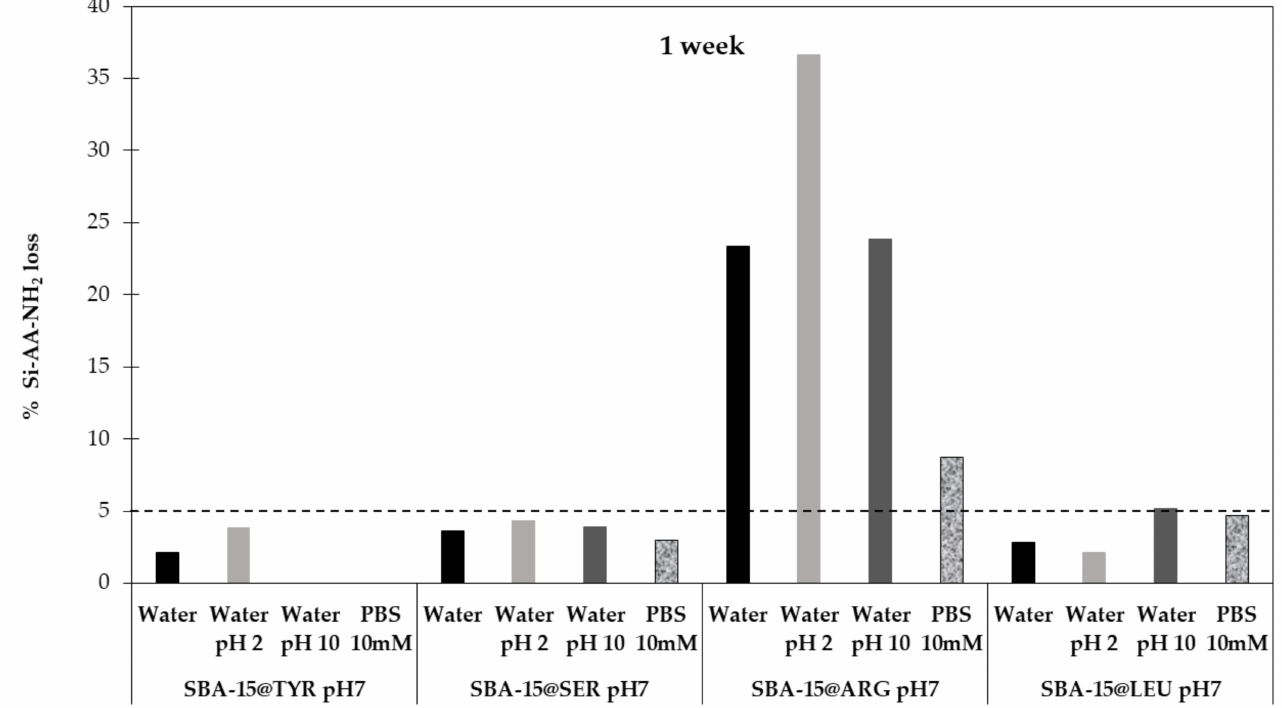
Figure 12. Percentage of Si-AA-NH 2 grafted lost after 1 week of incubation at different aqueous